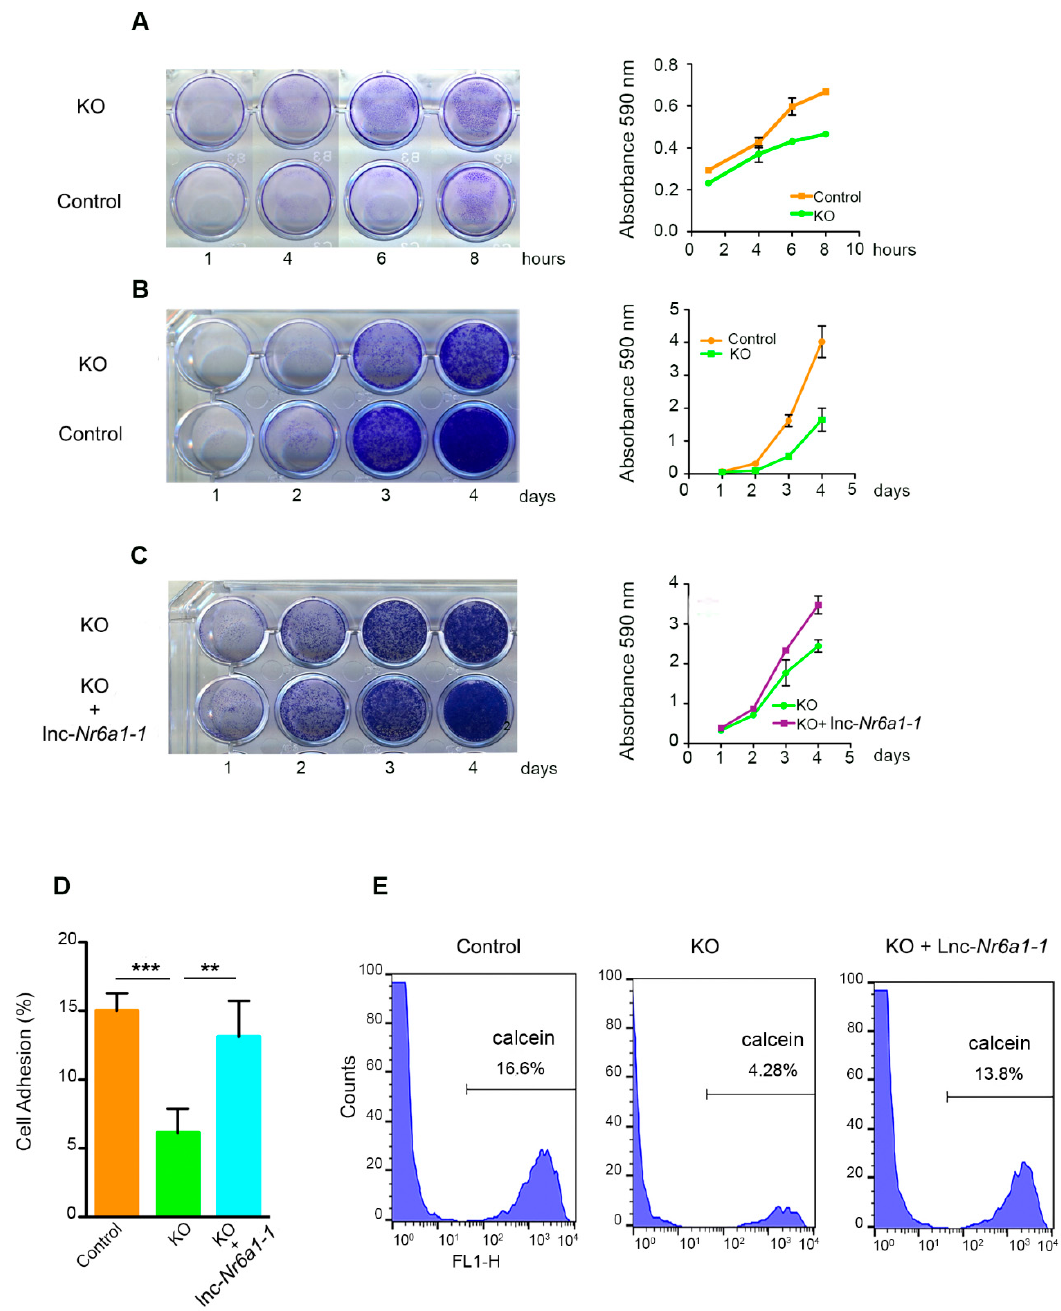
Figure 4. Lnc-Nr6a1 depletion affects cell adhesion. Scanned 60-mm Petri dishes with fixed colonies subjected to crystal violet staining assays, ( A , B ) control cells and Lnc-Nr6a1 -depleted cells, ( C ) Lnc- Nr6a1 -depleted cells and Lnc-Nr6a1 -depleted cells overexpressing lnc- Nr6a1-1 isoform. Cells were plated on dishes and incubated for indicated times. Stained adherent cells were solubilized with 1% SDS at room temperature for 30 min and quantified at OD 590 nm. Experiments were performed in triplicate, and data are expressed as the mean ± S.D. from three independent experiments. ( D , E ) Flow cytometric analysis of control, Lnc-Nr6a1 -depleted and Lnc-Nr6a1 -depleted cells, overexpressing lnc- Nr6a1-1 calcein-labeled cells. Labeled cells were added to a confluent monolayer of unstained NMuMG cells incubated for 2 h and adherent cells quantified by flow cytometry analysis. The bar graph shows mean ± S.D. of six independent experiments, *** p < 0.001, ** p < 0.01 via two-tailed Student’s t -test.